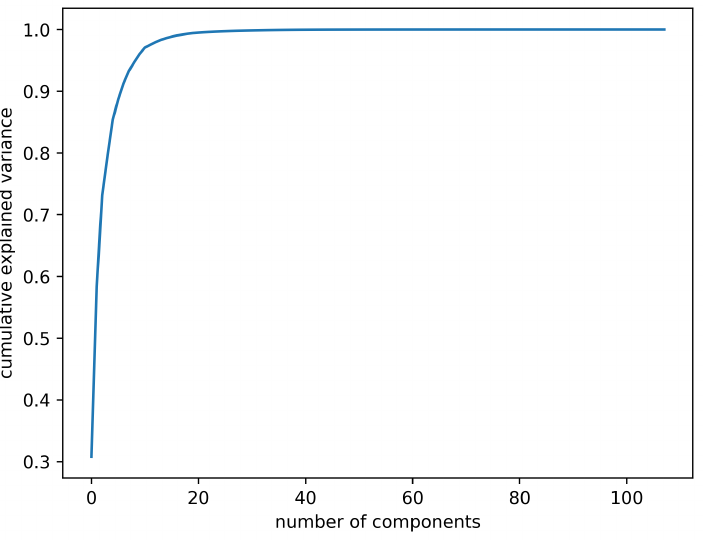
Figure A4. Principal component analysis in real industrial dataset.